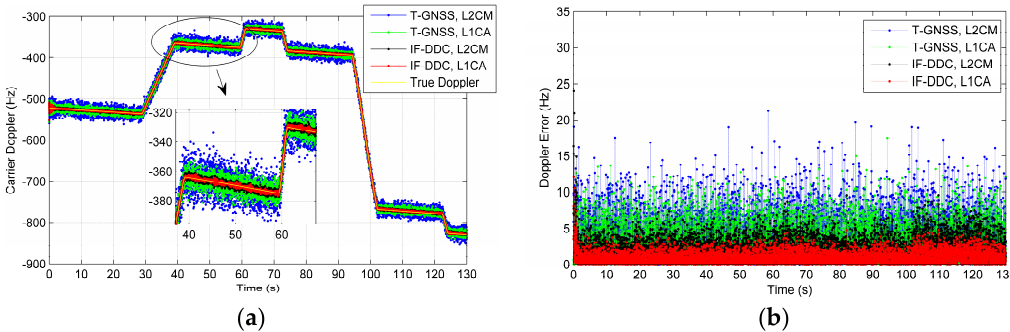
Figure 12. Carrier frequency tracking performance of SV #25: ( a ) carrier Doppler; ( b ) Doppler error.